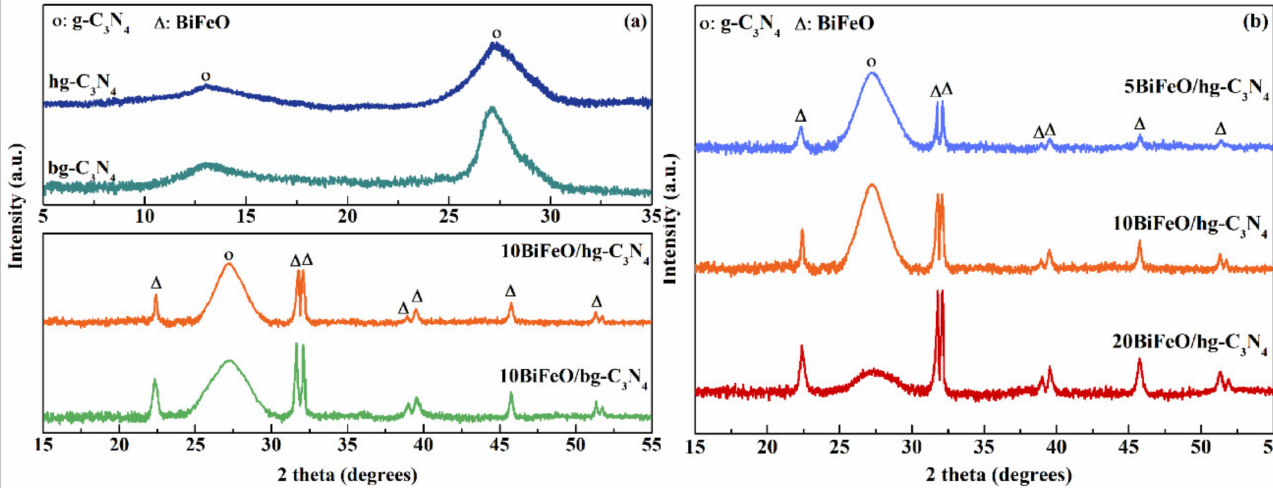
Figure 1. XRD patterns of following catalysts: ( a ) hg-C 3 N 4 , bg-C 3 N 4 , 10BiFeO/hg-C 3 N 4 , and 10BiFeO/bg-C 3 N 4 ; ( b ) x BiFeO/hg-C 3 N 4 (5%, 10%, and 20% BiFeO 3